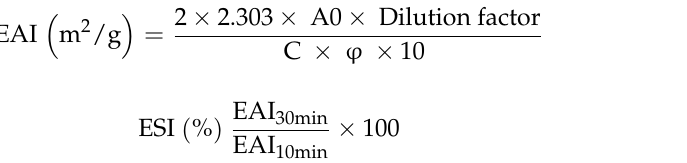
Table 1. Compositional analysis of two batches of African oil bean (AOB) seeds (in %, w / w ). Sample Moisture Ash Lipid Protein Carbohydrates AOB1 6.8 ± 0.3 b